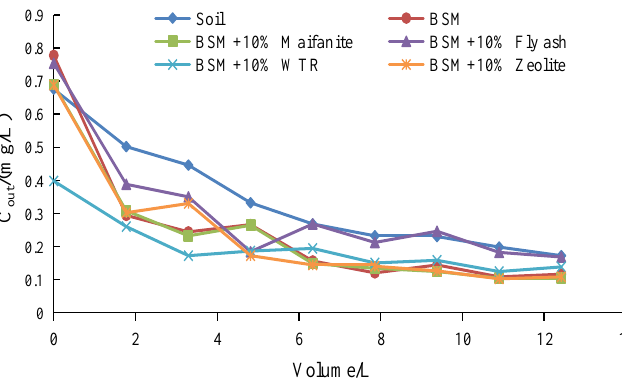
Figure 5. Dynamic desorption curve of phosphorus in modified fillers.